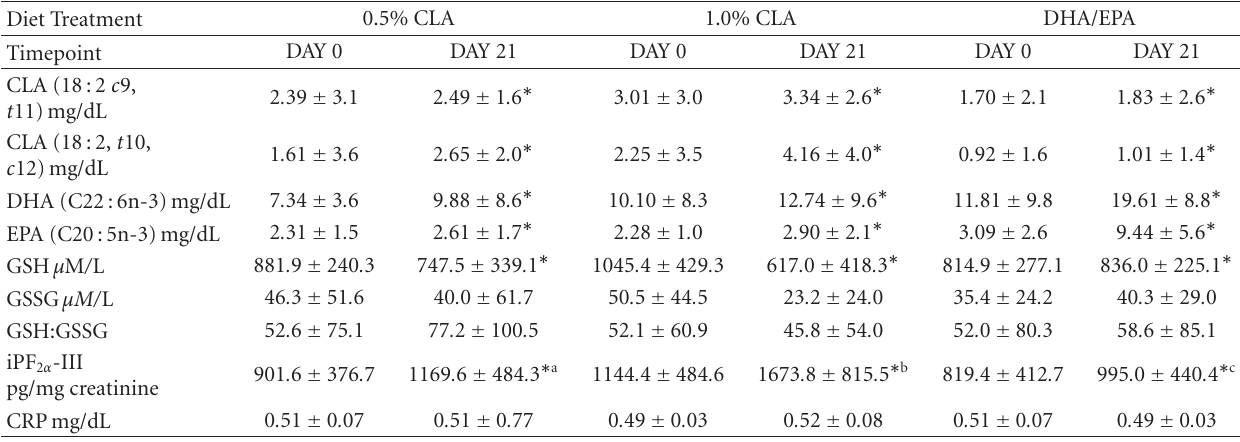
Table 1: Summary of e ff ect of PUFA dietary supplementation on PUFA levels and indices of oxidant injury and inflammation. Results reported as mean and standard deviation. The symbol ∗ denotes significant change between Day 0 and Day 21 measurements and superscript letters indicate significant di ff erences between treatment groups. CLA Conjugated linoleic acid DHA docosahexaenoic acid